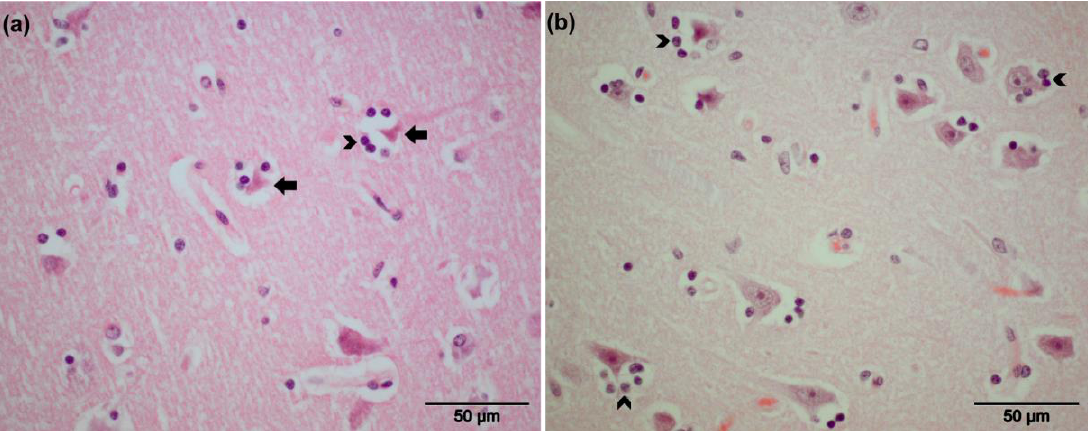
Figure 2. Histopathology of cerebral cortex (Grevy’s zebra, CG3) showing degenerated neurons (arrows) ( a ) with mild glial reactions (head of arrows) in ( a , b ); HE staining.